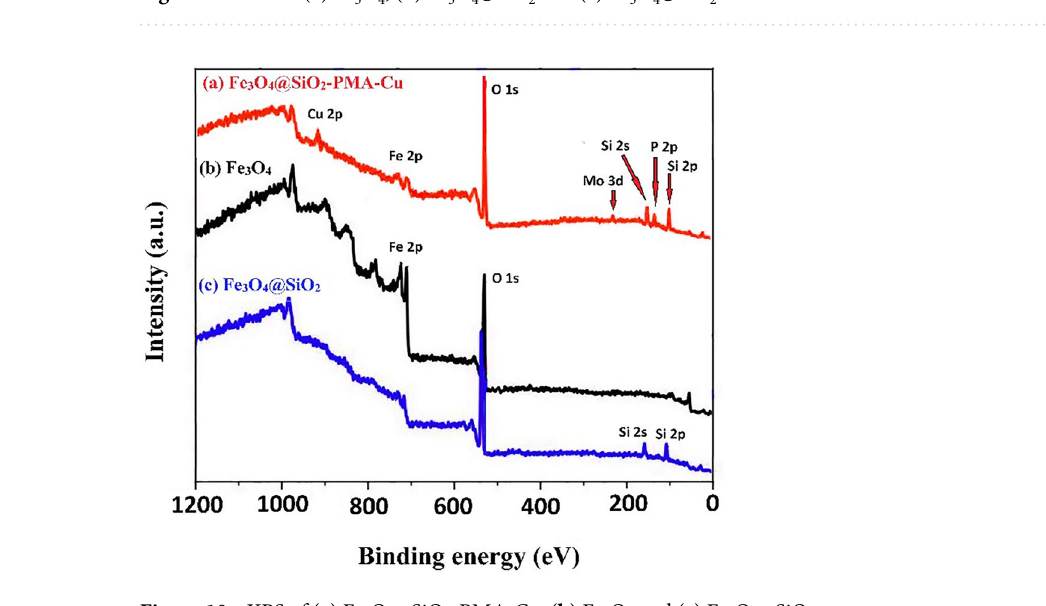
Figure 9. EDS of ( a ) Fe 3 O 4 , ( b ) Fe 3 O 4 @SiO 2 and ( c ) Fe 3 O 4 @SiO 2 -PMA.